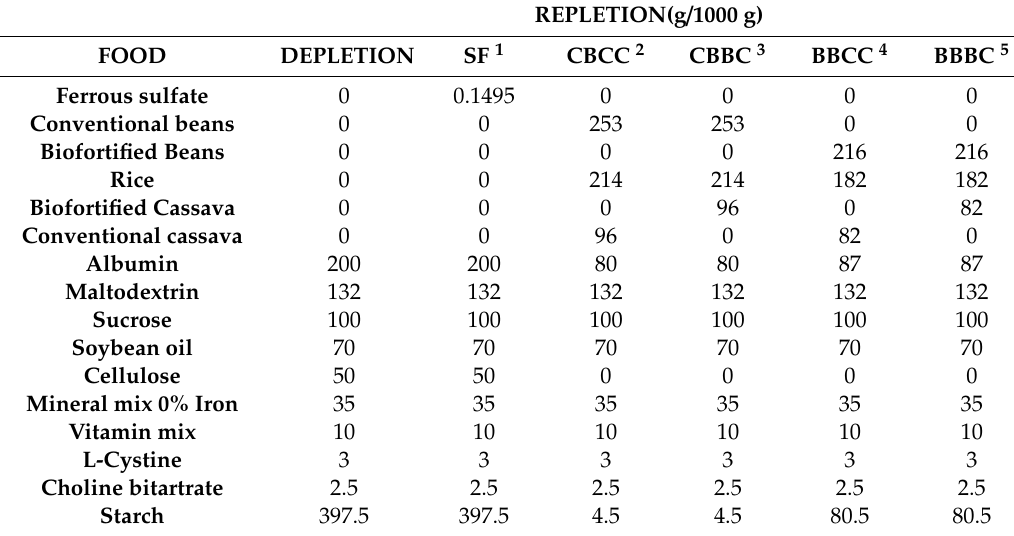
Table 1. Composition of the diets’